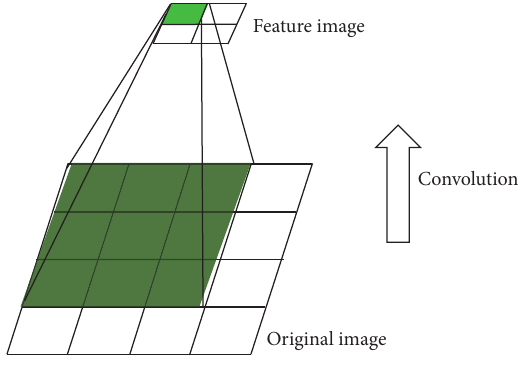
Figure 2: The process of convolution.